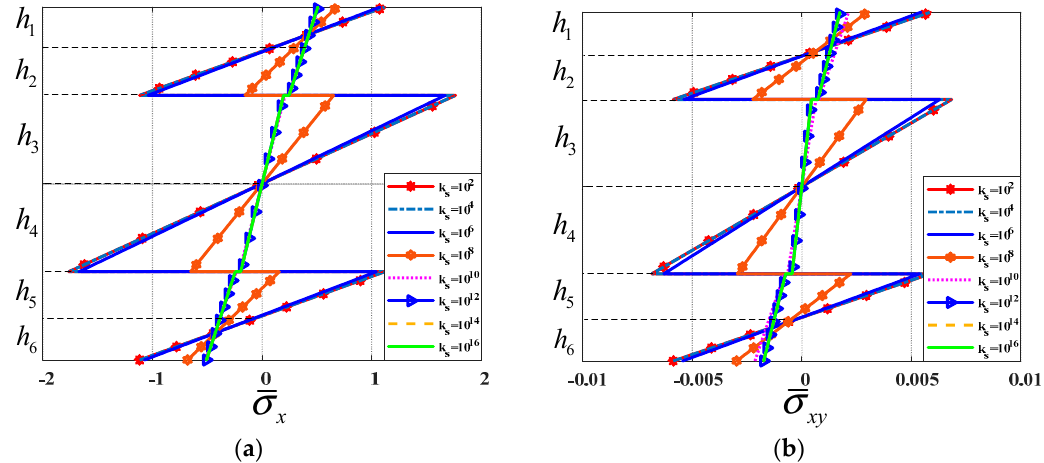
Figure 5. Non-dimensional stress of the plate center point when the load moves to the plate center point. ( a ): Nondimensional stress σ x versus thickness, ( b ): Nondimensional stress σ xy versus thickness.